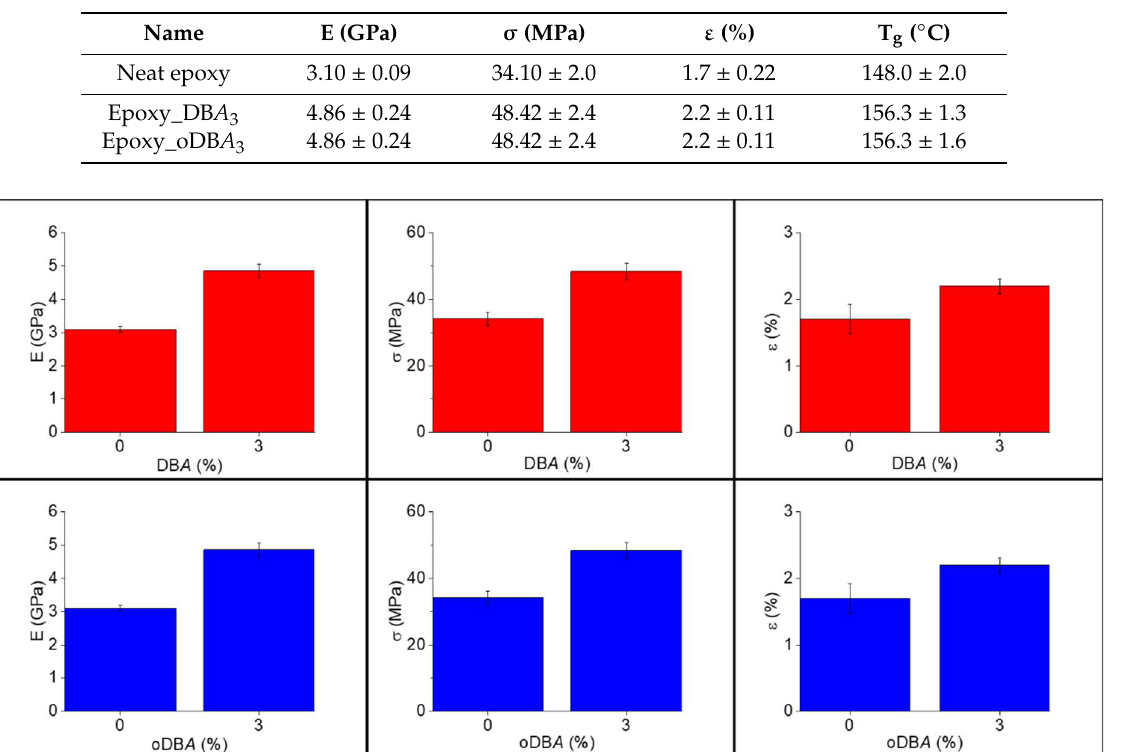
Table 7. Mechanical properties and glass transition temperature of the epoxy composites obtained after dynamic DSC scans up to 250 ◦ C.